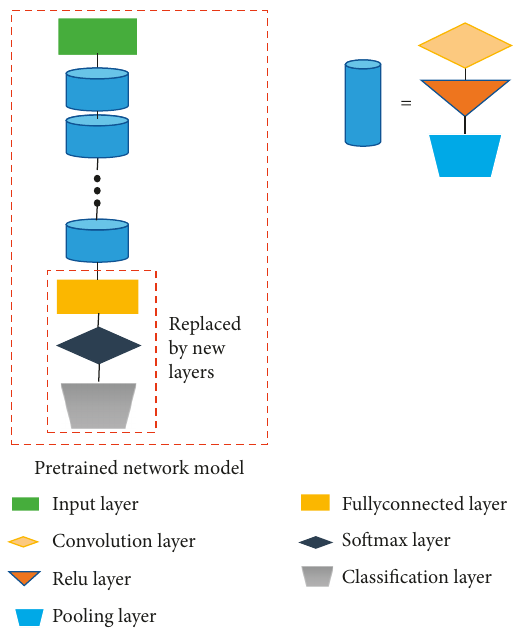
Figure 5: Model-based transfer